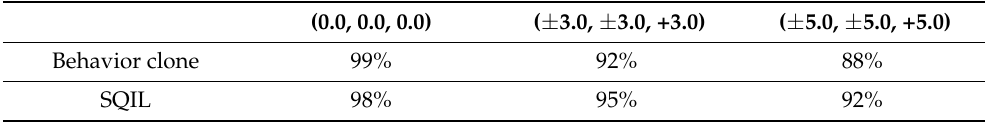
Table 4. Pouring task robustness